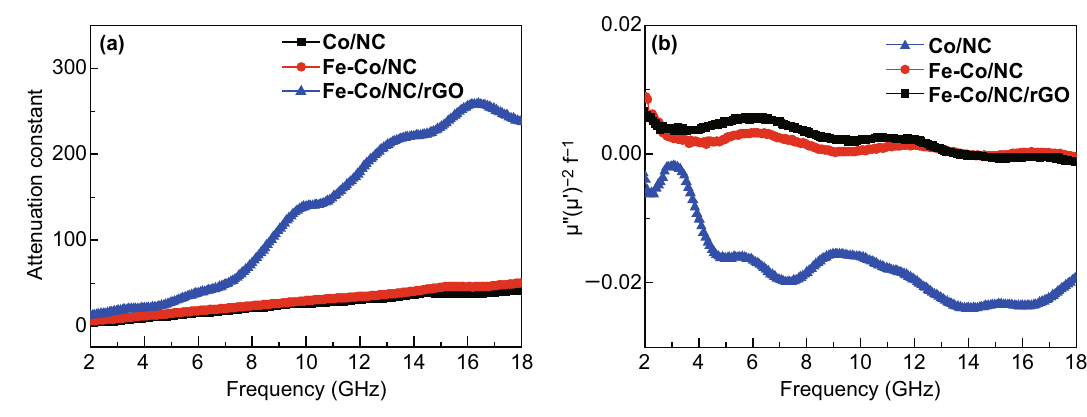
− 2 f − 1 𝜇 � of Co/NC, Fe–Co/NC, and ( )